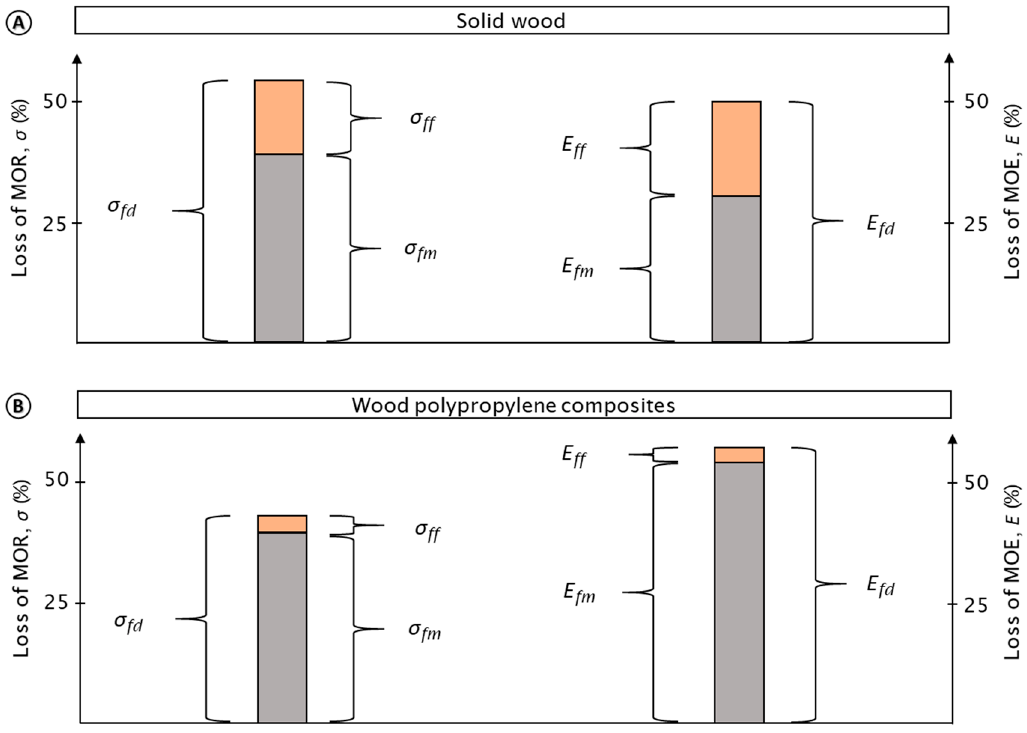
Figure 3. Mean percentage loss in the modulus of rupture (MOR) and modulus of elasticity (MOE) for wood ( A ) and wood–polypropylene composites (WPC) ( B ). Loss in MOR / MOE caused by the entire test procedure ( σ fd ; E fd ), moisture ( σ fm ; E fm ), and fungi ( σ ff ; E ff ) are presented, respectively. In total, eight variants of WPC, two variants of wood, and one variant of pure polymer were analyzed. The